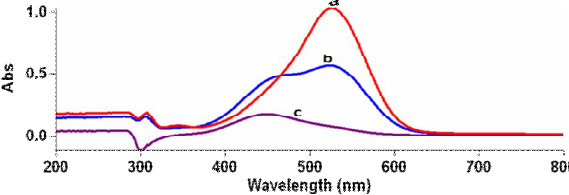
Fig. 4. The effect of treatment efficiency of neutral red solution (5 ppm) after 3 h in different conditions, (a) without UV irradiation, (b) with UV and (c) with UV and Fe O @SiO /TiO for neutral red. 3 4 2 2